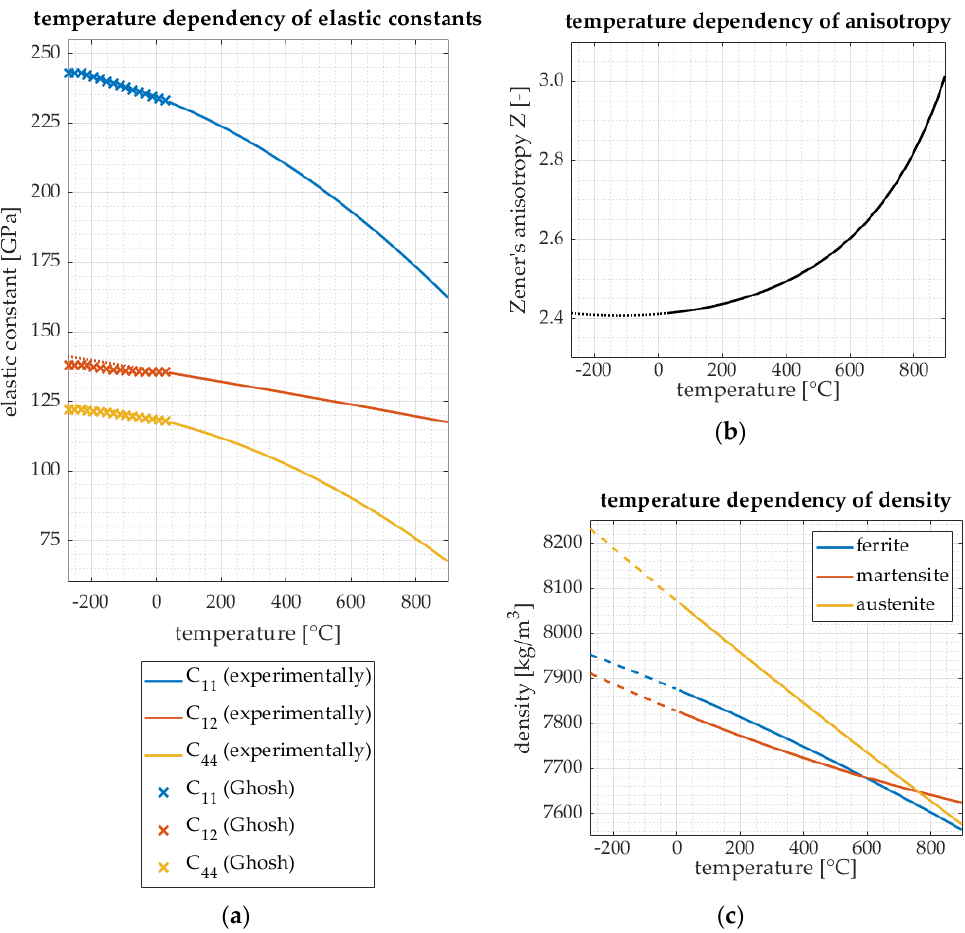
Figure 4. ( a ) The elastic coefficients 𝐶 11 , 𝐶 12 , and 𝐶 44 of ferrite plotted as function of temperature between room temperature and 900 °C as a solid line. An extrapolation down to the absolute minimum temperature is shown as a dotted line. Values as given by Ghosh [41] are shown as crosses; ( b ) the isotropy 𝒵 as derived from the temperature-dependent elasticity coefficients; and ( c ) the temperature-dependent densities of ferrite, martensite and of austenite [51,52].